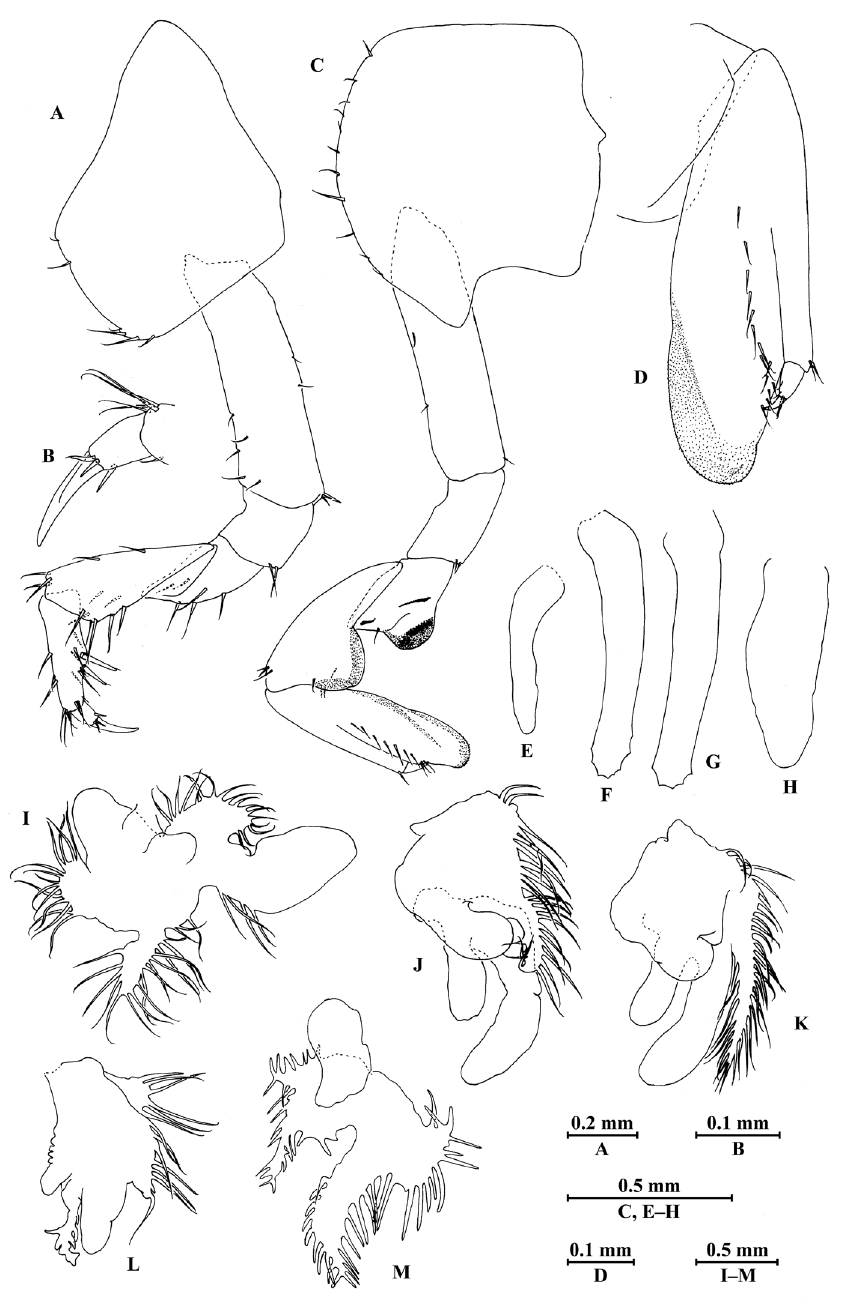
Figure 3. Myanmarorchestia peterjaegeri Hou, sp. n., female holotype. A gnathopod I B dactylus of gnathopod I C gnathopod II D propodus of gnathopod II E oostegite of gnathopod II F oostegite of pereopod III G oostegite of pereopod IV H oostegite of pereopod V I coxal gill of gnathopod II J coxal gill of pereopod III K coxal gill of pereopod IV L coxal gill of pereopod V M coxal gill of pereopod